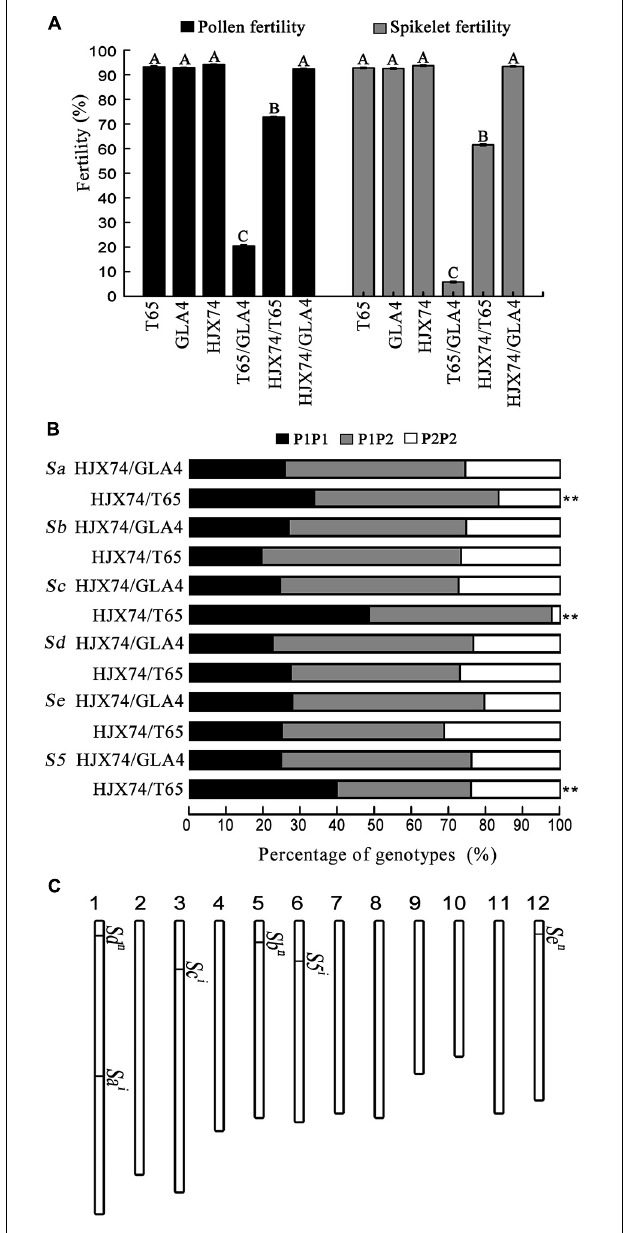
FIGURE 1 | Genotypes of hybrid sterility loci Sa , Sb , Sc , Sd , Se , and S5 in HJX74. (A) Pollen and spikelet fertility of three parents and their F 1 hybrids. (B) Ratios of genotypes at Sa , Sb , Sc , Sd , Se , and S5 loci in the F 2 populations from the crosses between HJX74 and testers Taichung 65 (T65) and Guang-lu-ai 4 (GLA4). (C) Chromosome location and genotypes of the genes at the Sa , Sb , Sc , Sd , Se , and S5 loci in HJX74. Vertical bars represent rice chromosomes. P1P1, Genotypes of HJX74; P1P2, Heterozygous genotype; P2P2, Genotype of testers T65 ( S j / S j ) or GLA4 ( S i / S i ). Capital letters indicate statistical differences at the 0.01 probability